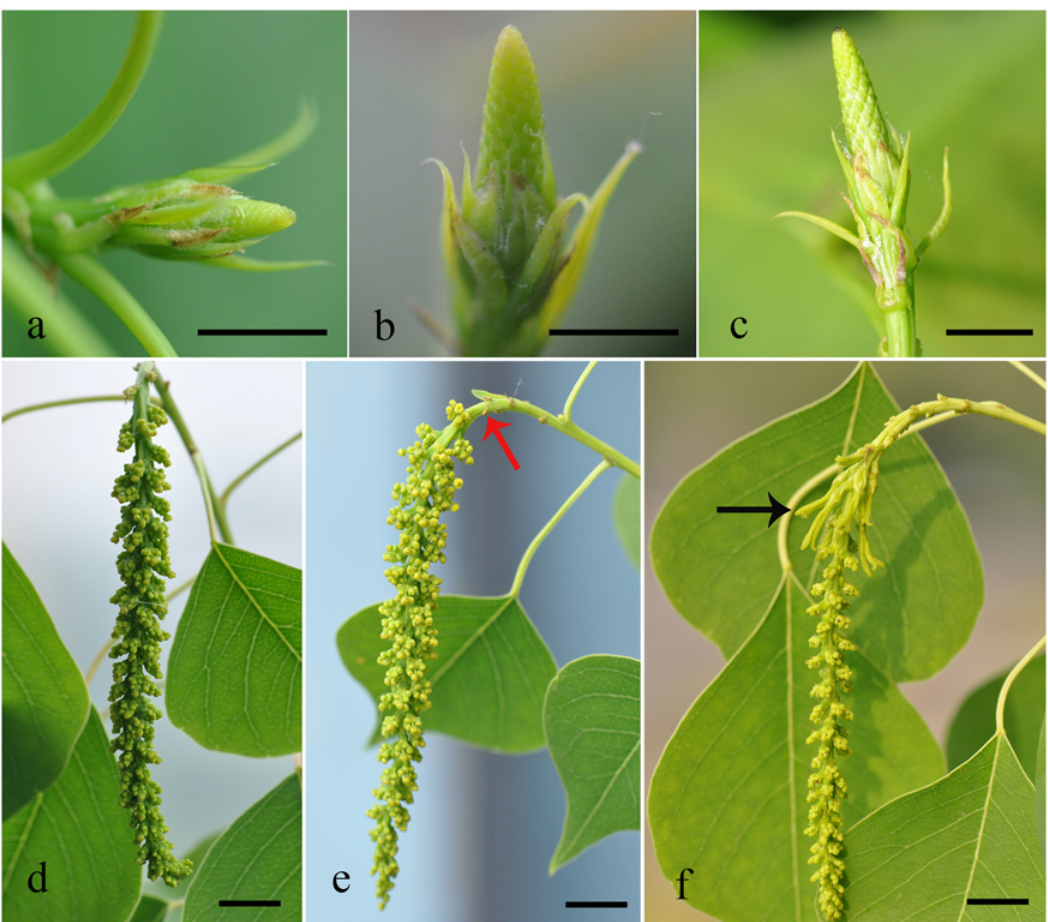
Fig 1. Flower development stages in S. sebiferum . S. sebiferum flower development can be divided into six fine stages: a. inflorescence bud swelling; b. inflorescence emergence; c. inflorescence expansion; d. staminate flower partially open with pistillate flower buds emergence; e. staminate flower fully open with pistillate flower buds expansion; f. pistillate flower fully open. Scale bar = 1 cm. Red arrow represents pistillate flower bud and black arrow represents pistillate flowers.